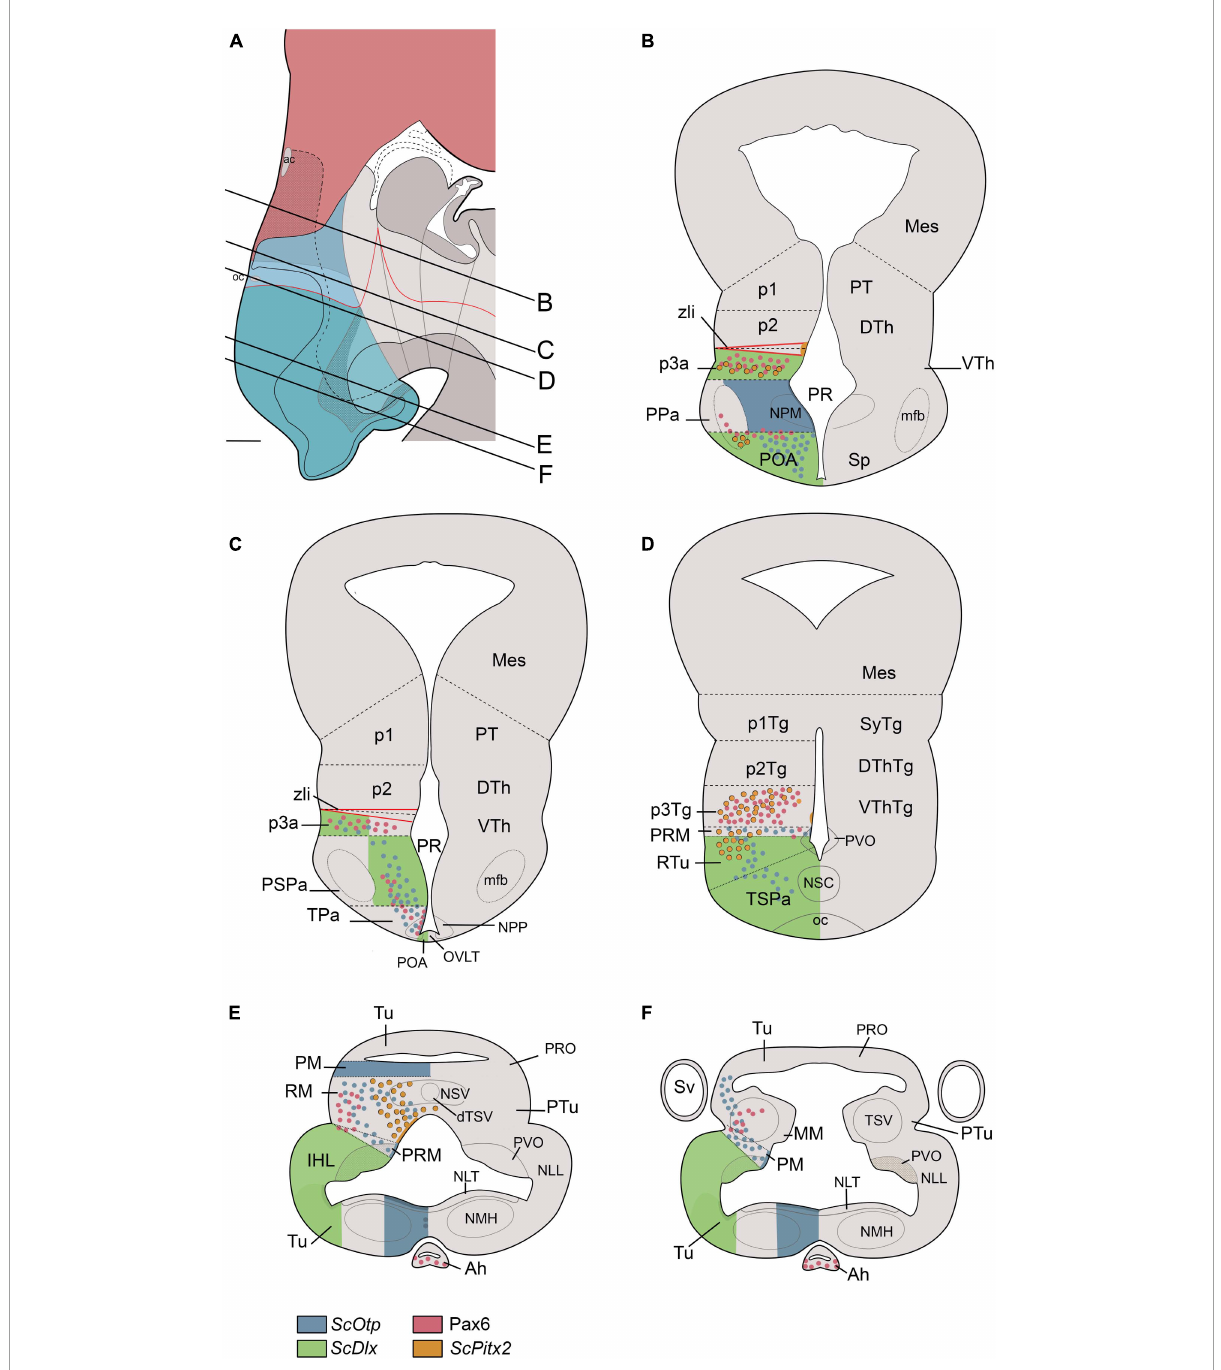
FIGURE7 Transverse schematic representations of Scyliorhinus canicula hypothalamus at stage 32 according to prosomeric (left) and columnar (right) frameworks. Lines in (A) represent the level of transverse sections in (B–F) . Territories in (A) are colored as in Figure 6B . For abbreviations, see